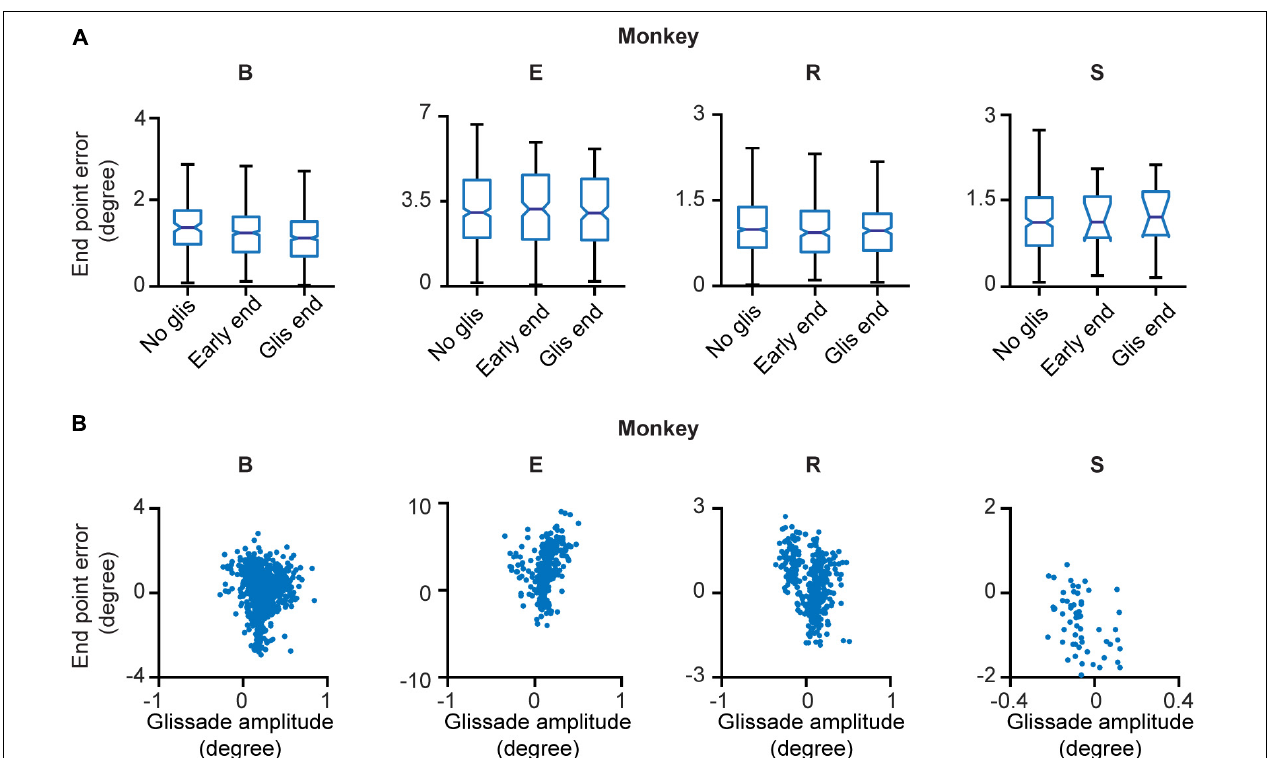
FIGURE 4 | End point errors at onset and offset of the glissade and of saccades without a glissade. (A) The first box in every panel represents the average endpoint error of saccades without a glissade (“No glis”). The second box represents the end point error of the saccade at the onset of the overshooting glissade (“Early end”; green arrow in Figure 1B ). The third box shows the end point error of the saccade at the end of the overshooting glissade (“Glis end”; blue arrow in Figure 1B ). No significant differences were observed. (B) Scatter plots of signed end point saccade errors (negative – hypometric saccades; positive – hypermetric saccades) and glissade amplitudes (negative – undershoots; positive – overshoots) of individual animals. See Supplementary Table 2 for p -values of (A) and correlation coefficients of (B) . Labels “B,” “E,” “R,” and “S” denote each of the four